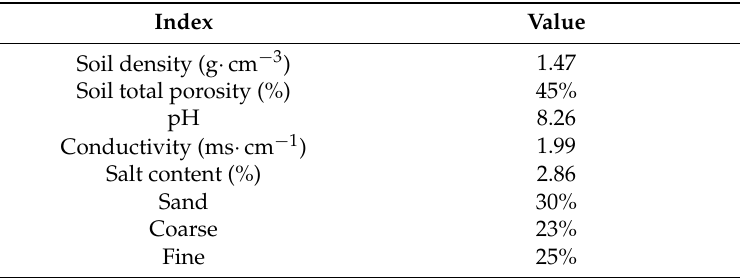
Table 1. Characteristics of tested